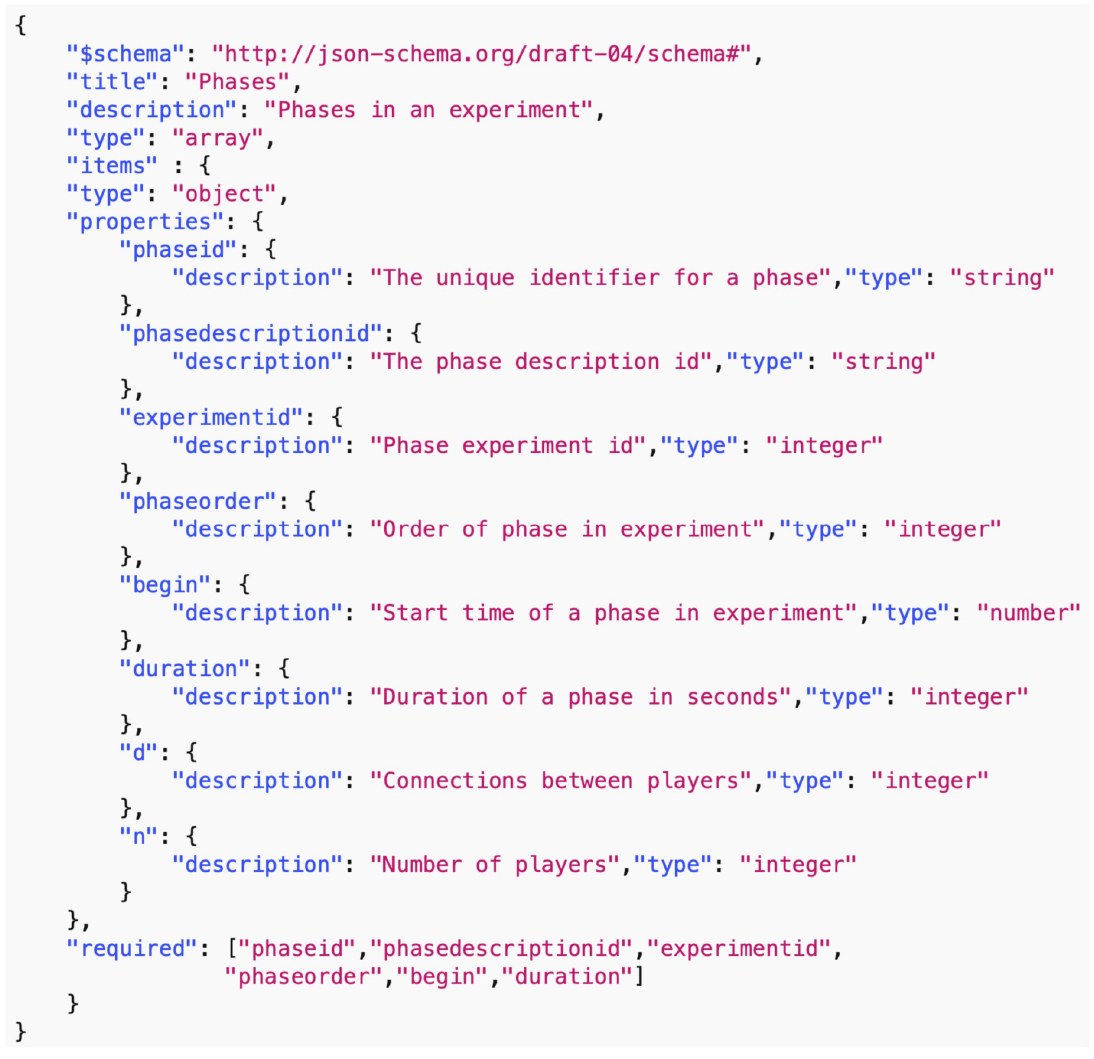
Fig 20. JSON schema for the “Phase” of the data common